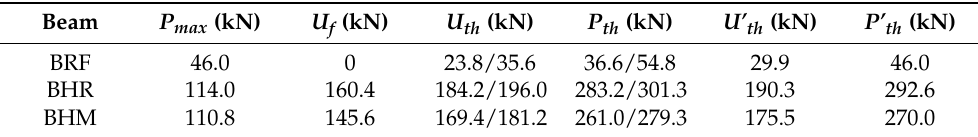
Figure 7. Rods and straps model used for the analysis. Table 9. Results of analysis via the rods and straps